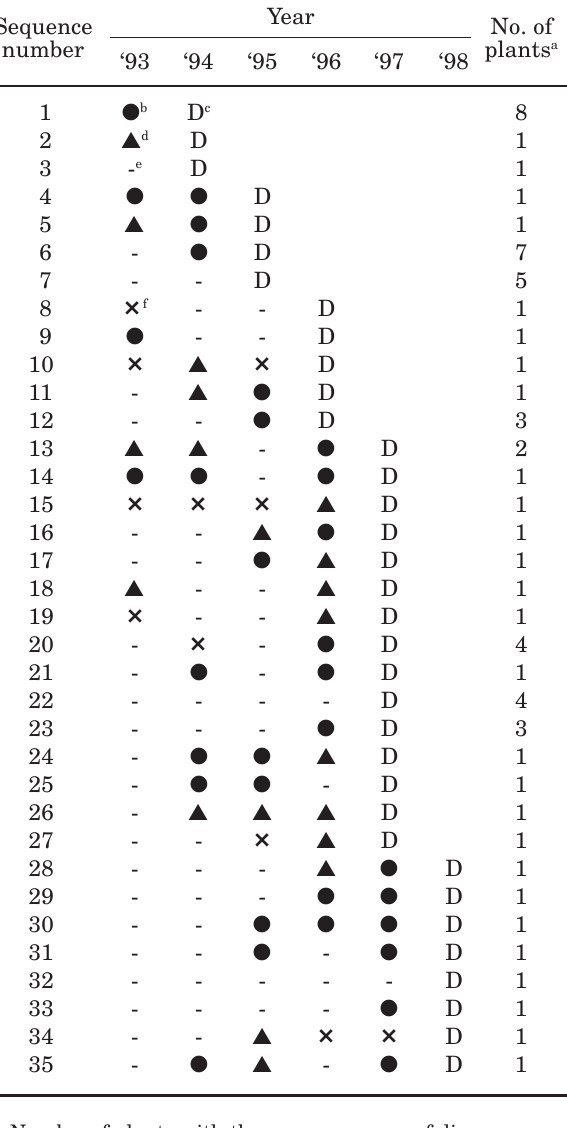
Table 6. Sequence of external esca symptoms in a vine- yard at Gambassi Terme (Florence) in the year(s) be- fore the plant(s) died of